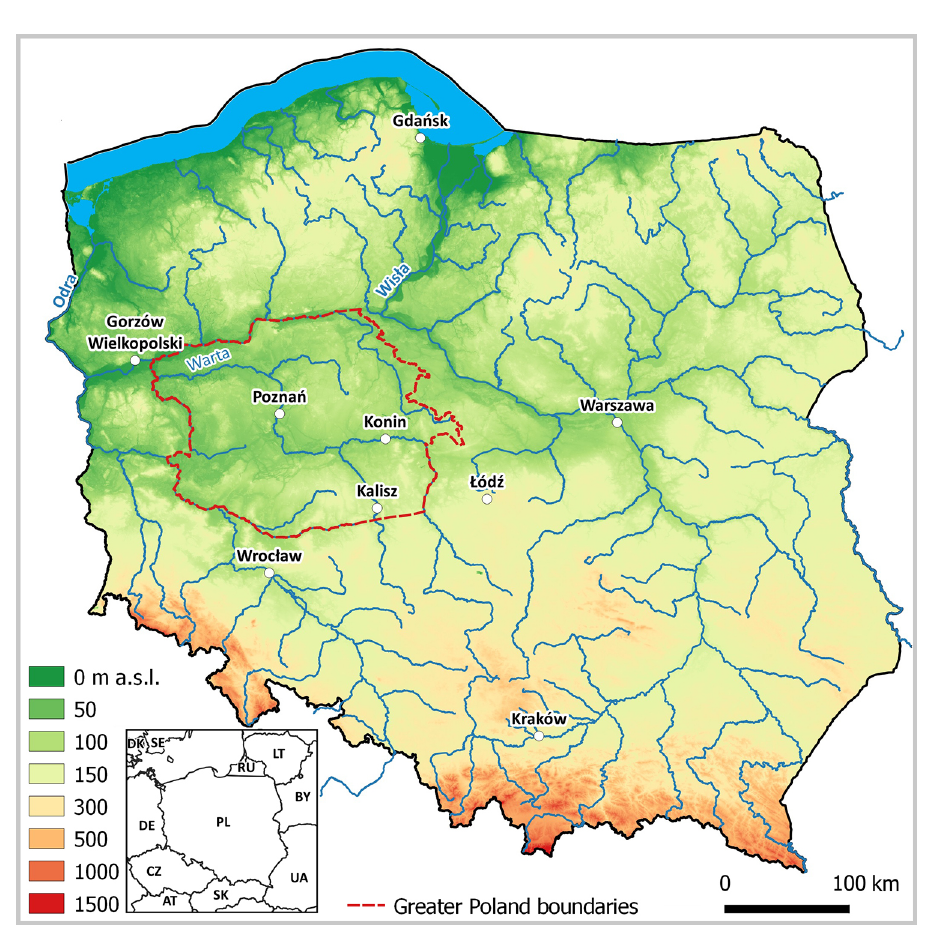
Fig. 1. Geographical position of the Greater Poland region in